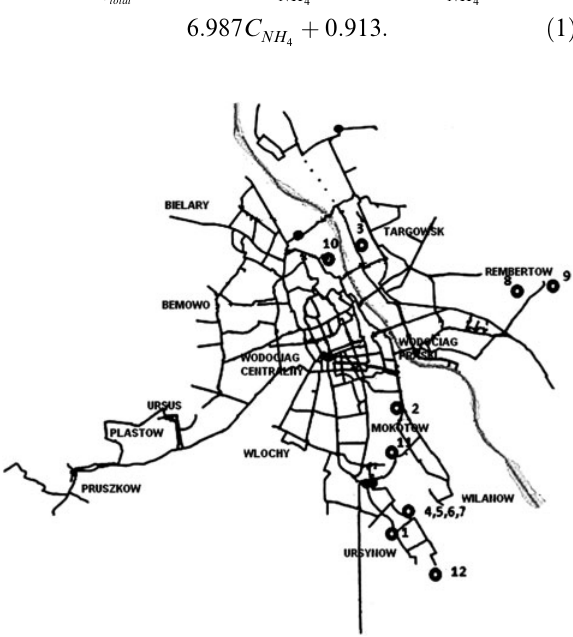
Fig. 2. Sampling scheme of Warsaw water supply network